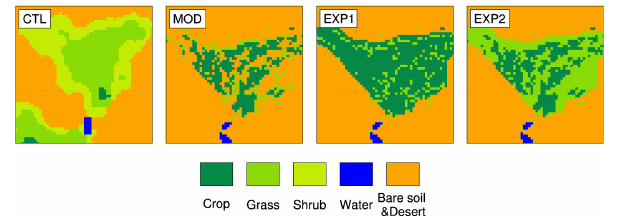
Fig. 2. Land use maps for the third domain of the four simulations.